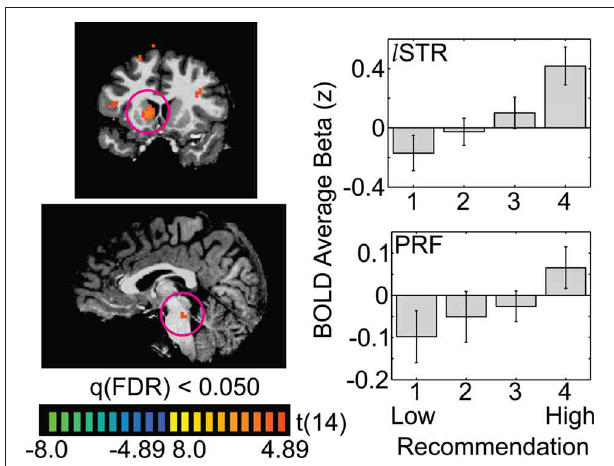
FIGURE 4 | Two subcortical regions show linear deflections centered around their resting baseline. The whole-brain images illustrate the t -statistic for the 4-vs.-1 contrast. Panels on the right illustrate the average beta weight (as a z -score) for each recommendation level, averaged across 15 observers (STR = left striatum; PRF = pontine reticular formation). Error bars are standard errors of the mean across observers.